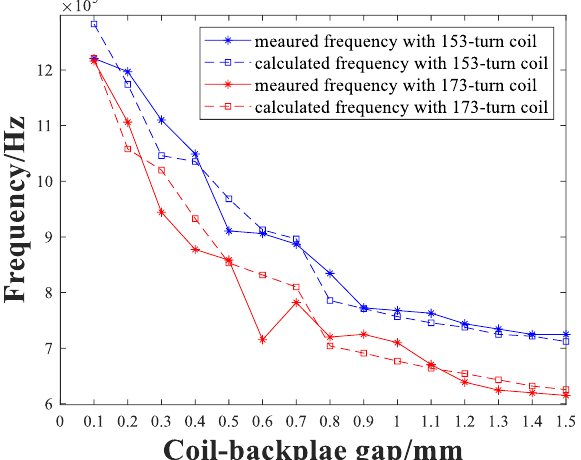
Figure 12. Measured and calculated frequencies of pulses with 153-turn coil and 173-turn coil.